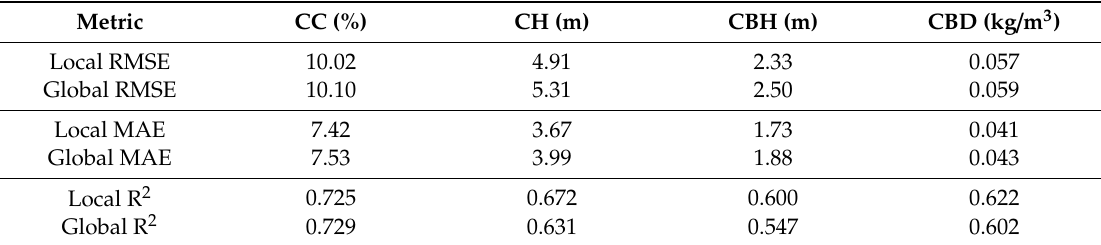
Table 3. Comparison of local models to the global model. Each landscape weighted equally in calculation of the mean accuracy metrics (i.e., not area weighted). Performance metrics are root mean square error (RMSE), mean absolute error (MAE), and the coe ffi cient of determination (R 2 ).